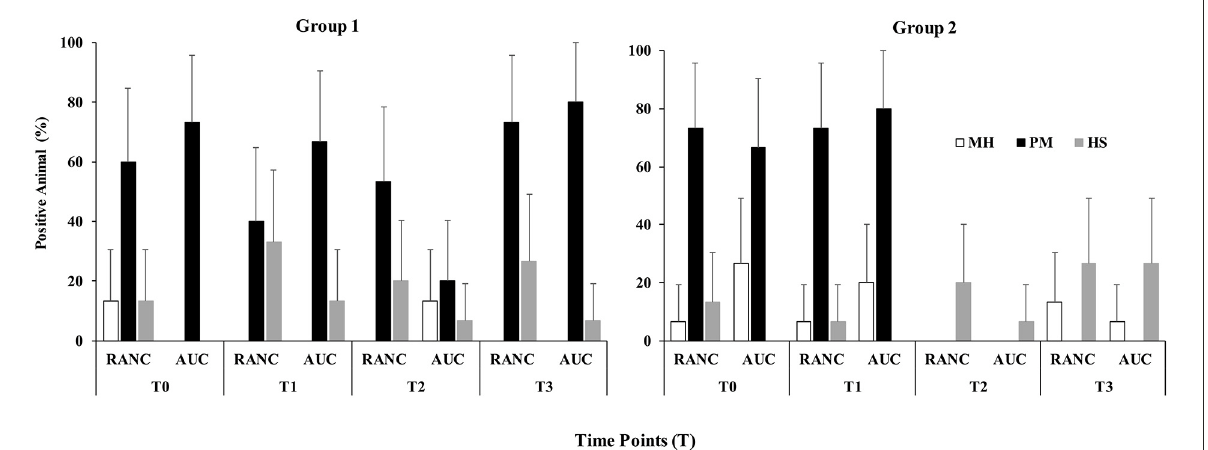
FIGURE2 Prevalence of M. haemolytica (MH), P. multocida (PM), and H. somni (HS) in DNS samples from auction-derived (AUC) and ranch-direct (RANC) cattle for Group 1 and Group 2. Isolation rates of M. haemolytica ( P > 0.05), P. multocida ( P > 0.05), and H. somni ( P > 0.05) did not differ between AUC and RANC at T1, T2, and T3 in both feedlots. The error bars represent 95% confidence interval.